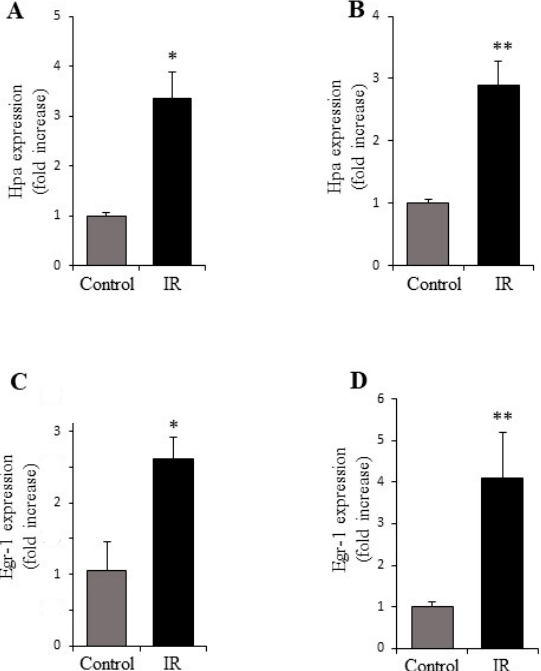
Figure 1. IR induces heparanase expression in kidney-derived cell lines. Prior to IR treatment, HK-2 human proximal tubule epithelial cells ( A , C ) and HEK-293 human embryonic kidney cells ( B , D ) were maintained for 16 h in serum-free medium. Cells either remained untreated (control) or were irradiated (IR) with 5 Gy ( A , C ) and 10 Gy ( B , D ). Heparanase (Hpa) and Egr-1expression were assessed by qRT-PCR. Error bars represent ± SE; * p ≤ 0.003, ** p = 0.013.